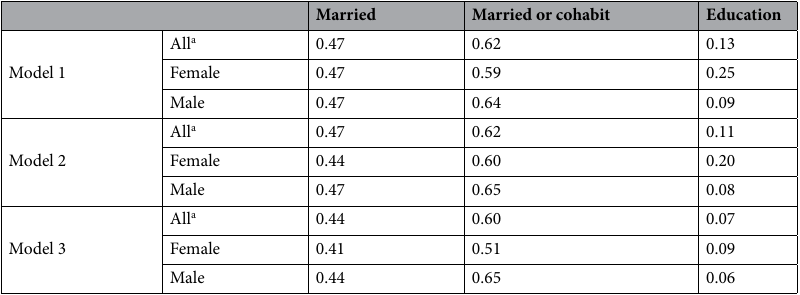
Table 4. Childhood hearing loss and number of children ever born. Proportion mediated by partnership status, education and health. Model 1—adjusted for age. Model 2—adjusted for age, mother’s and father’s education. Model 3—adjusted for age, mother’s and father’s education and self-reported health, systolic and diastolic blood pressure, motor, visual, somatic and mental impairment, and smoking. a Also adjusted for